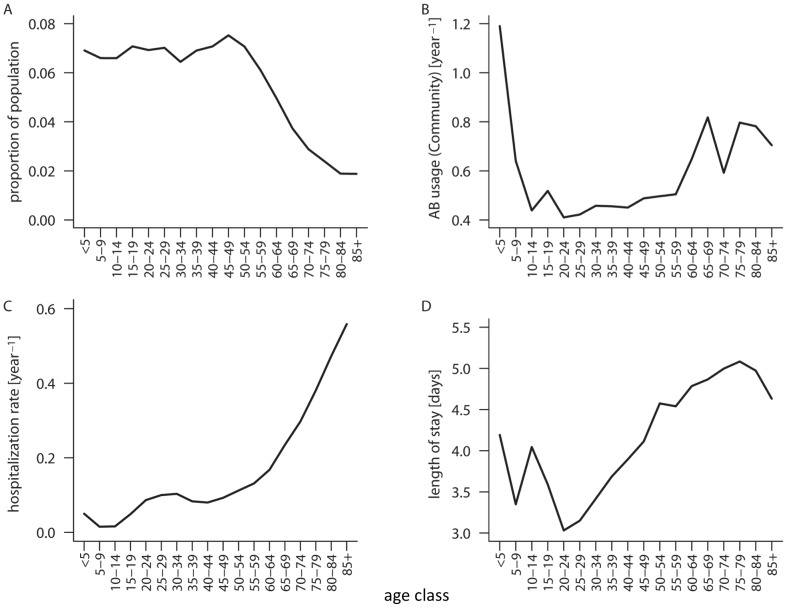
Distribution of the US population over age classes, age dependency of hospitalizations, treatment rates, and durations of hospitalization in the US.Data are shown for the 18 age classes used in the age-structured model.